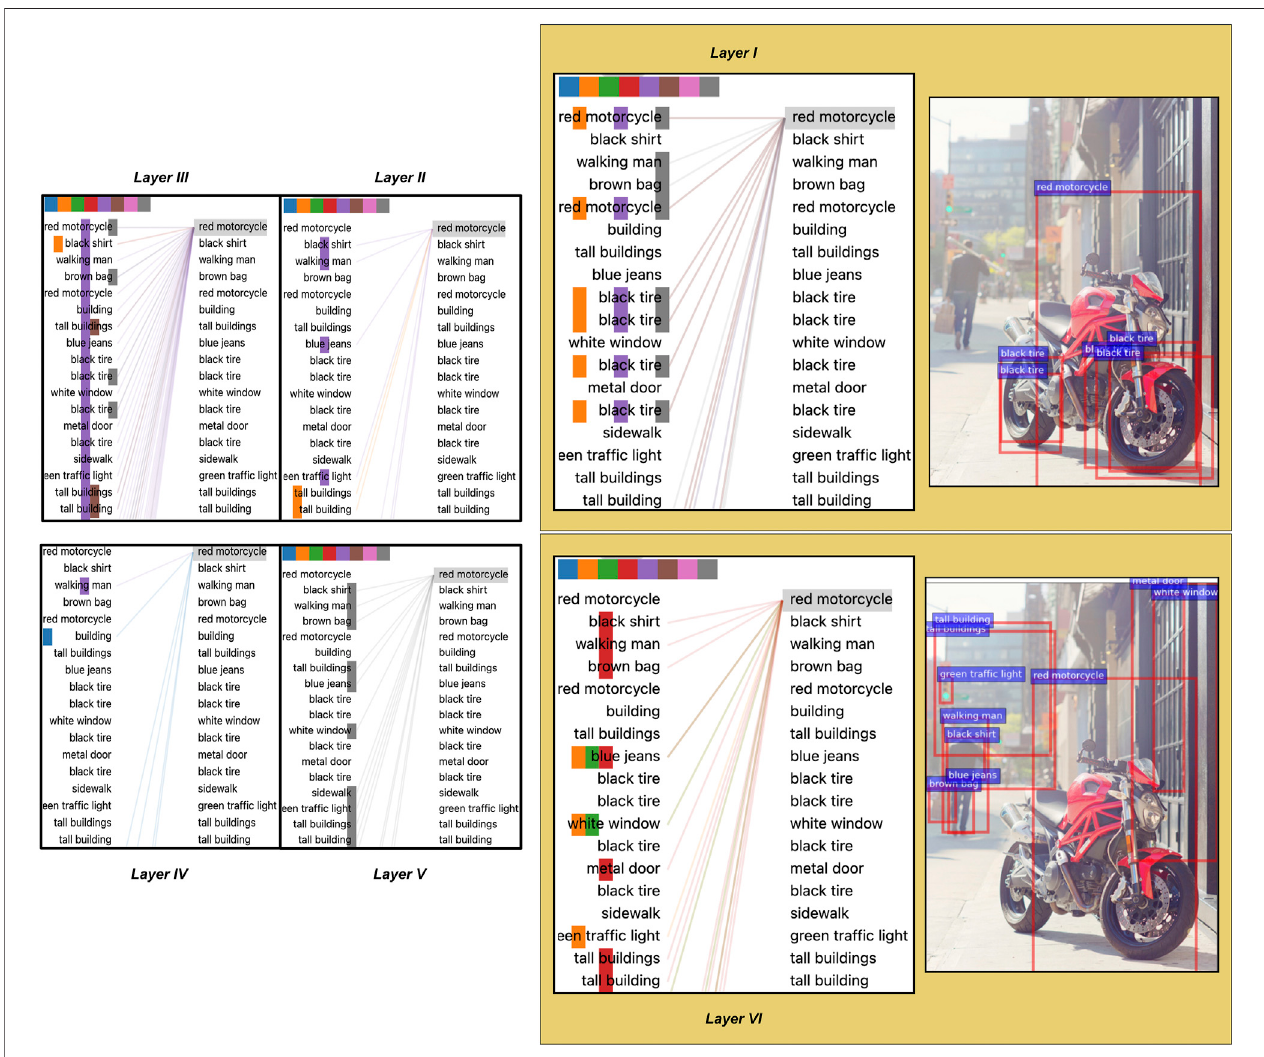
FIGURE 5 | An image with attention links between objects. Caption for the image: “ red motorcycle parked outside of large building in the city ” . All other details about this fi gure are as for Figure 4